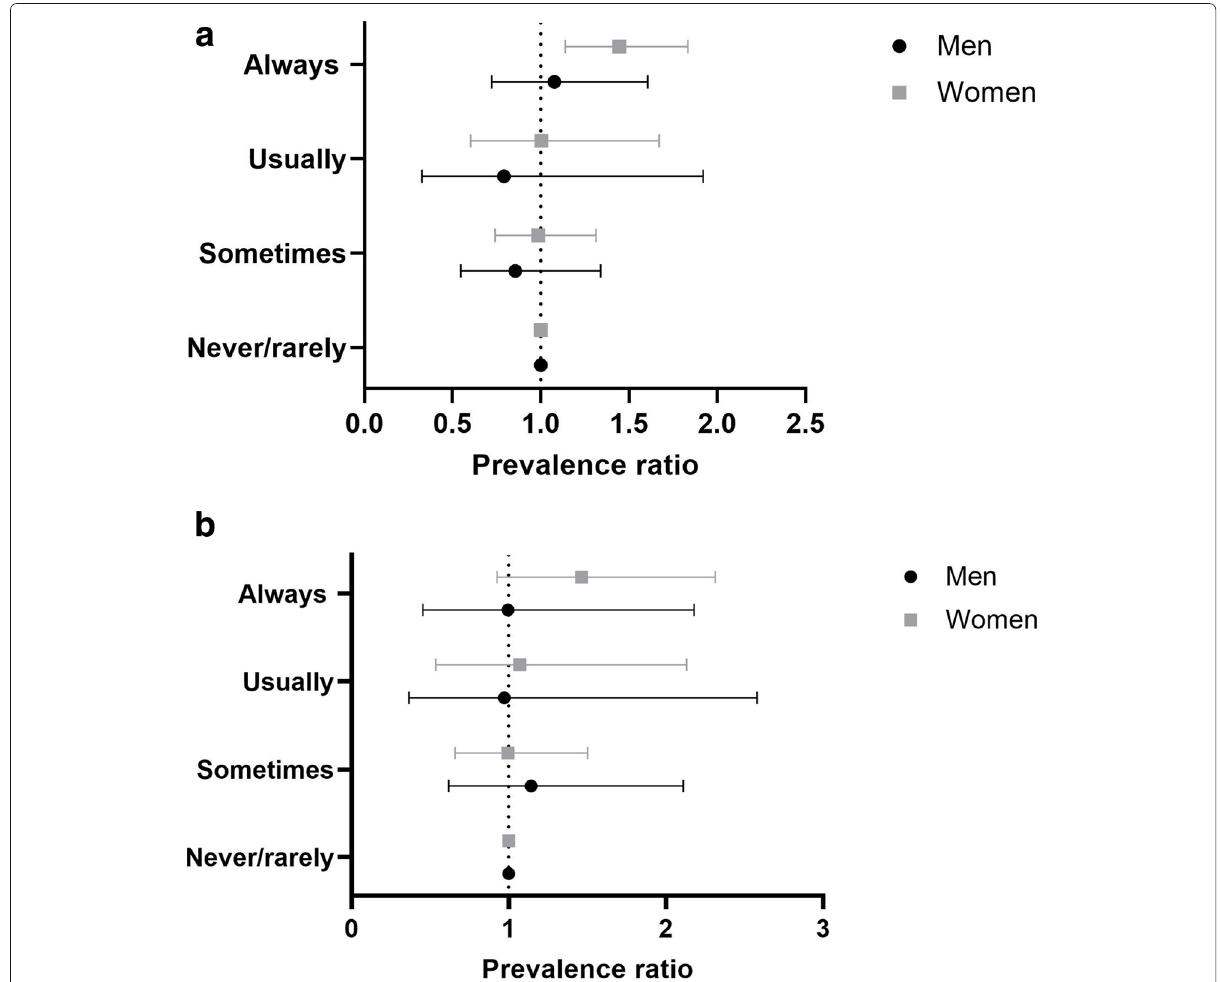
Fig. 5 Forest plot illustrating the prevalence of migraine among different occupational categories, divided by the type of shift work. Mean with error bars plots of the data from Table 5. The point estimate is the prevalence ratio (fully adjusted model) of migraineurs compared with controls among job categories, differentiated by frequency of (a) shift work and (b) night shift work